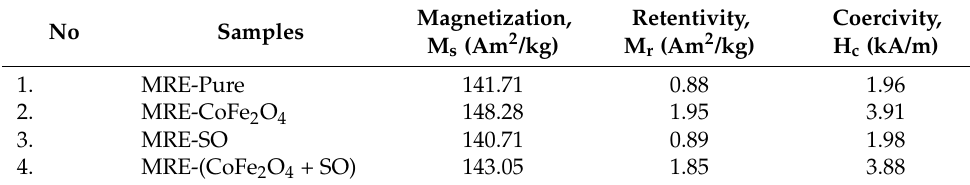
Table 3. Magnetic properties of MRE samples with/out additives.